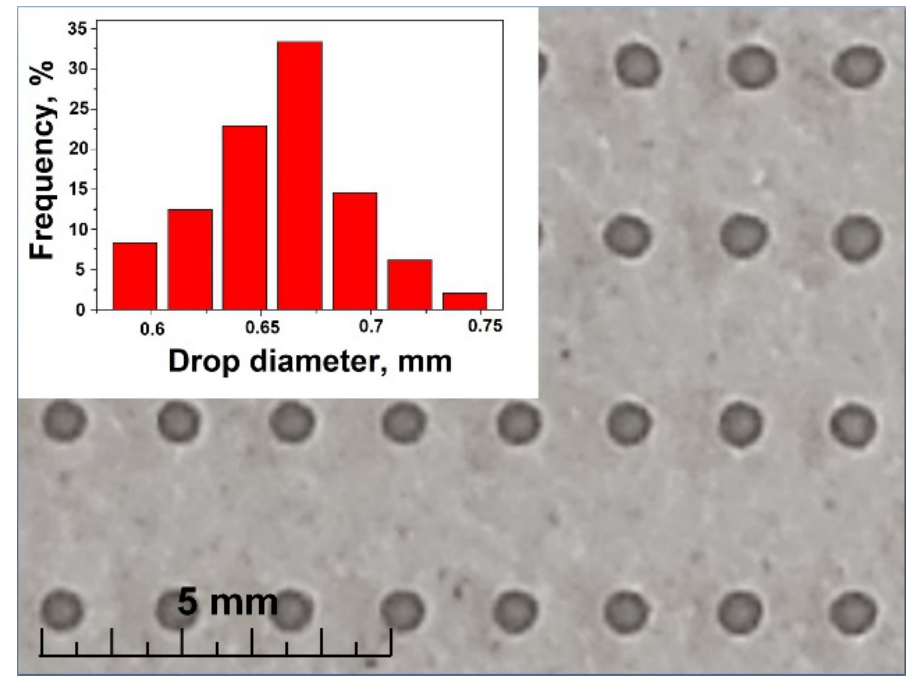
Figure 5. Photograph of the droplets printed with NiO/YSZ composite paste and droplet size distribution.